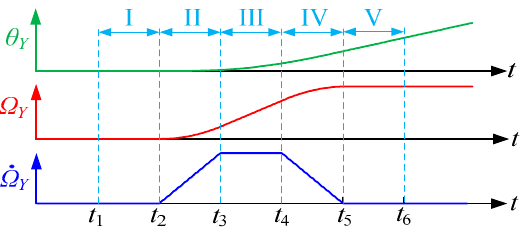
. Ω Ω Y and angle displacement θ Y in Y , rotating speed